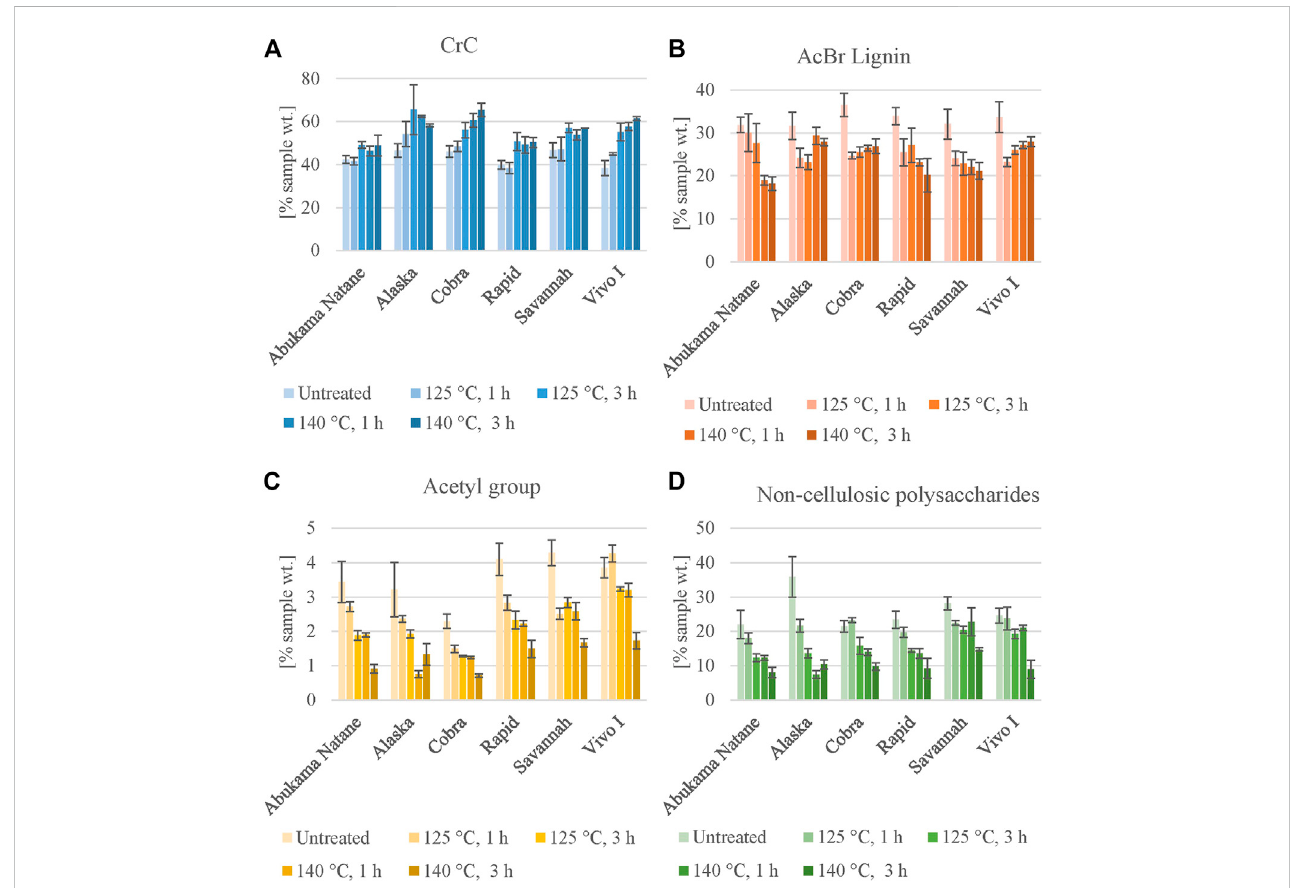
FIGURE 5 Changes in cell wall composition during OrganoCat pretreatment. Initial biomass is compared with pulps produced by different severities. Six selected lines were characterized biochemically (A) crystalline cellulose content (Seaman) (B) acetyl bromide lignin (C) acetyl groups o; (D) residual non-cellulosic polysaccharides of the pulp. Values are expressed as means ± standard deviation; n = 3.